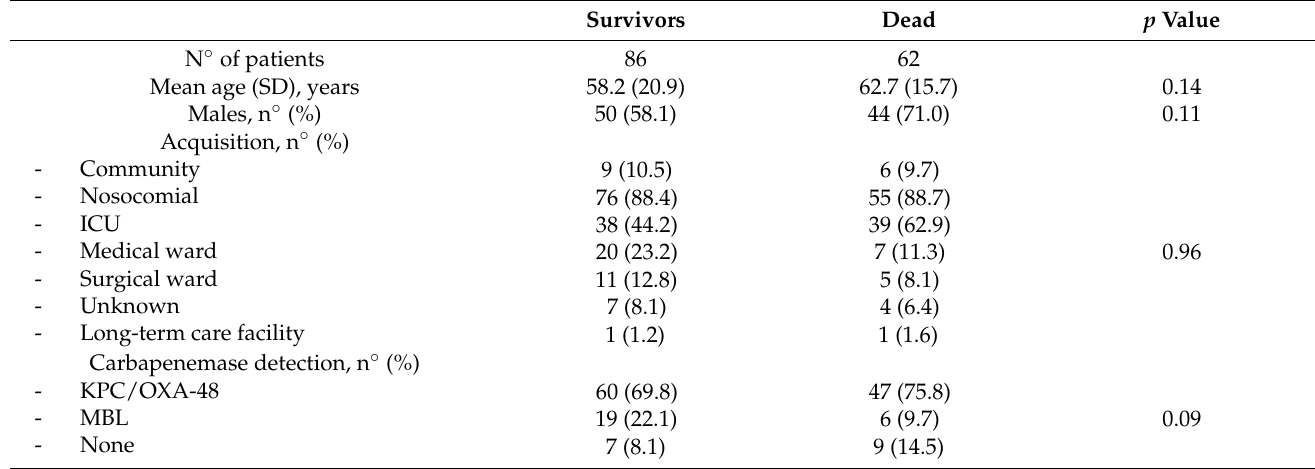
Table 4. Demographic, clinical and microbiological characteristics of patients according to 90-day